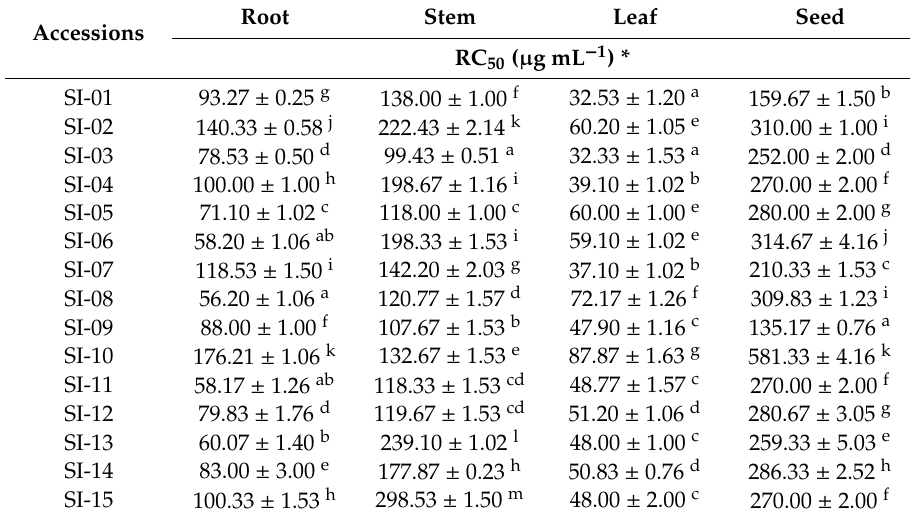
Table 6. Antioxidant activity of the selected accessions of S. italica.